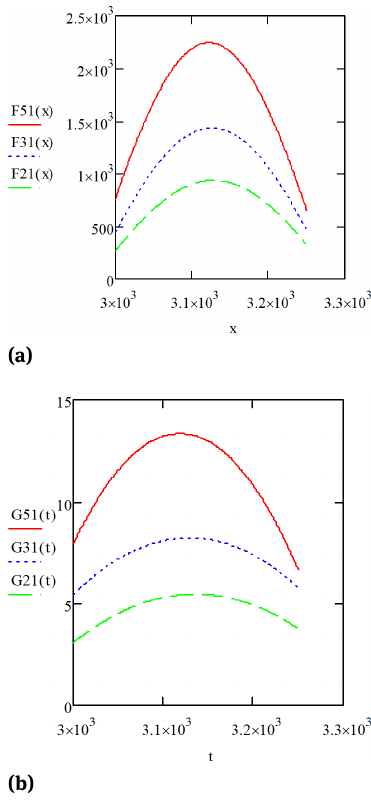
Figure 4. A graphical view of the Fourier images (graph (a)), and the trend line functions (graph (b)) for three different gasoline